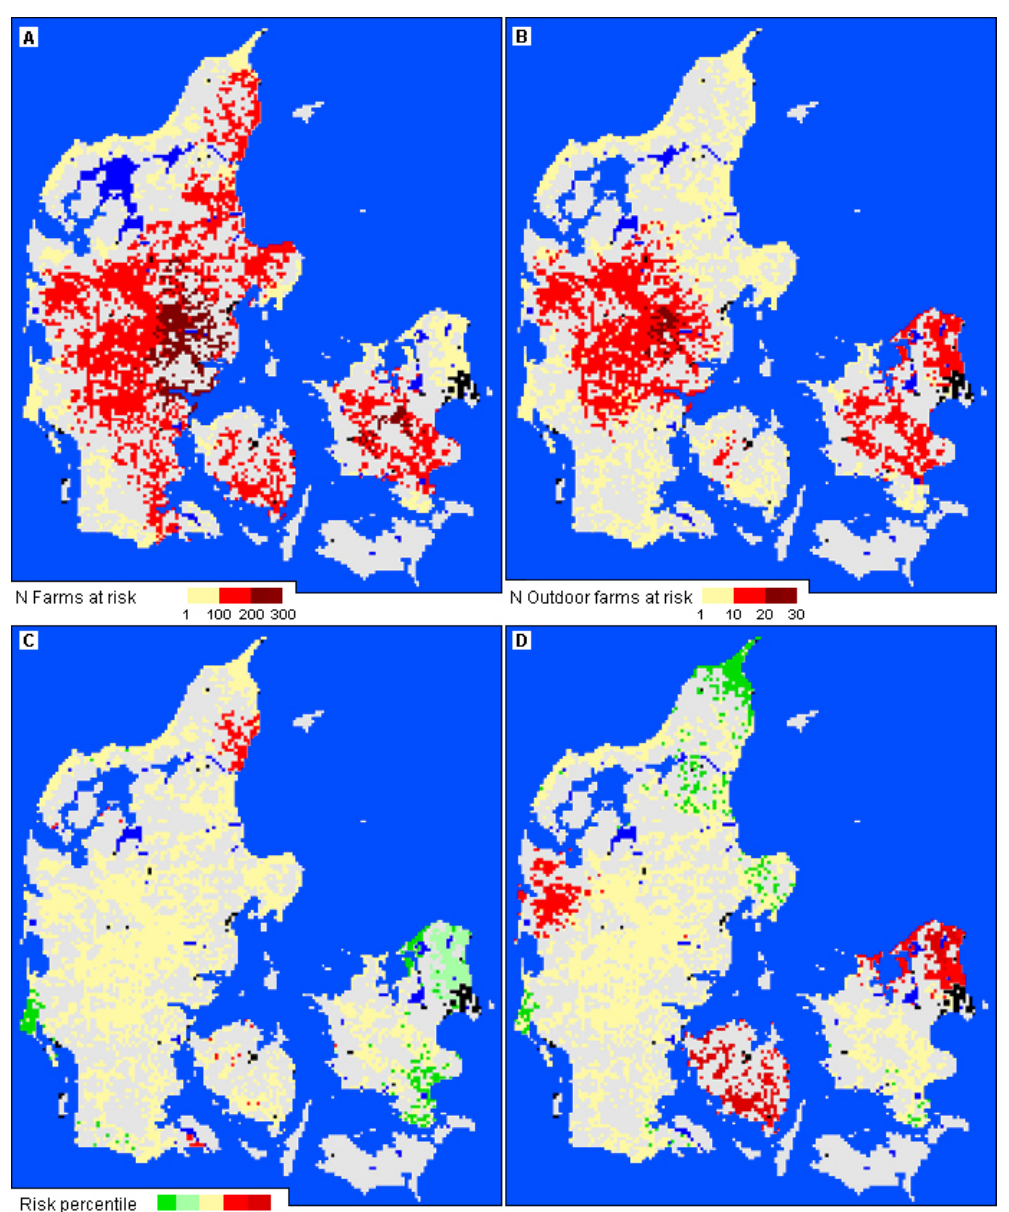
Fig. 5 . Contact risk between breeding wild boars and pig farms in Denmark as obtained from the simulation model. Colors represent the estimated risk from releases in each of the focal reintroduction cells. (A) Total number of farms in buffer areas of one cell around habitats in which boars breed, averaged for all simulations in each reintroduction cell; (B) same for extensive and other outdoor farms; (C) and (D) outlier distribution of farms at risk as compared to the null model of random farm distribution. Colors represent the percentile score of the estimated